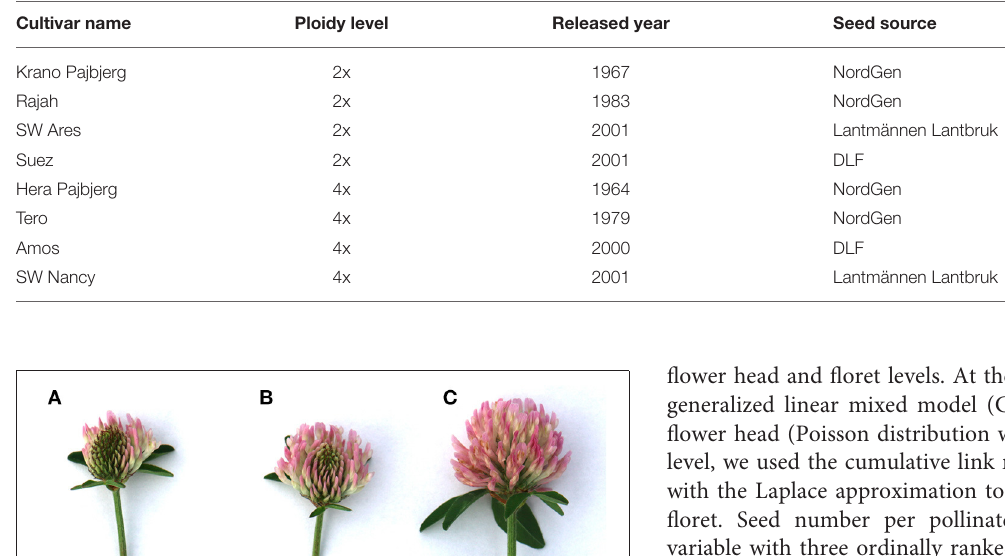
TABLE 1 | Plant materials information.